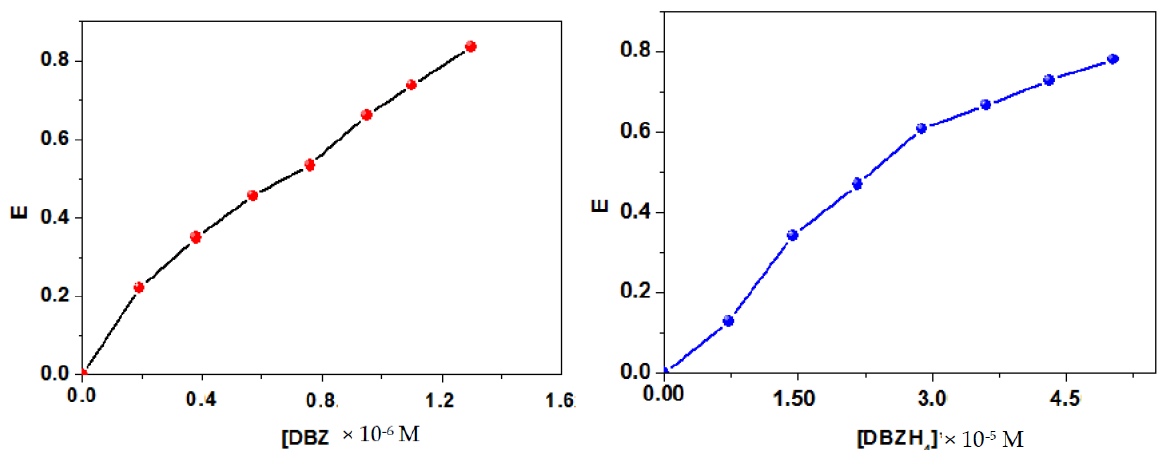
Figure 6. ( A ) Spectral overlap of the fluorescence spectrum of BSA with the absorption spectrum of DBZ ; ( B ) spectral overlap of the fluorescence spectrum of BSA with the absorption spectrum of DBZH 4 , T = 298 K.